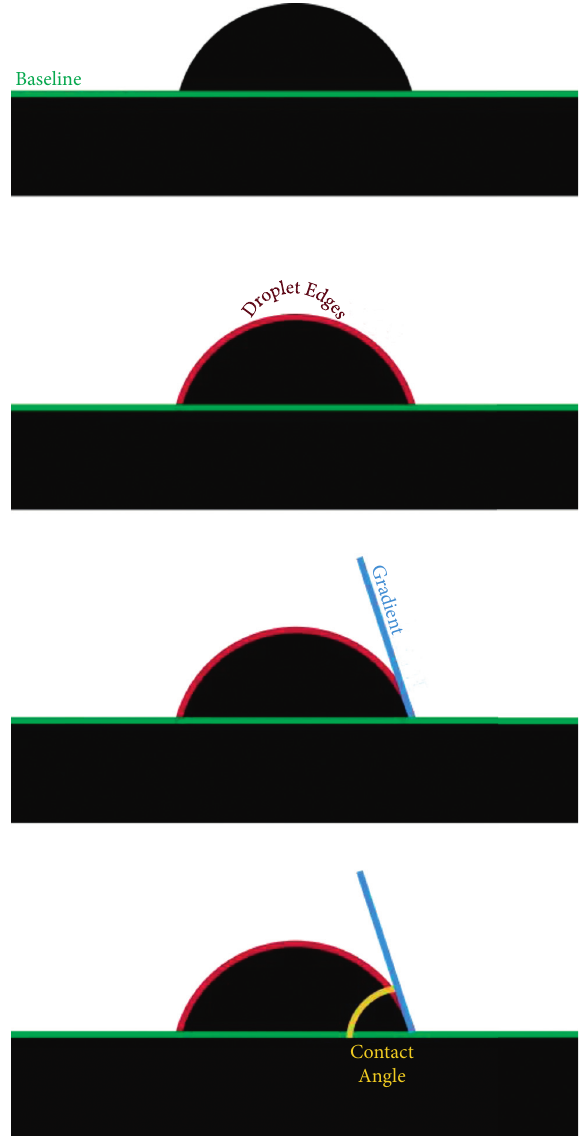
Figure 5: Stages of contact angle analysis.